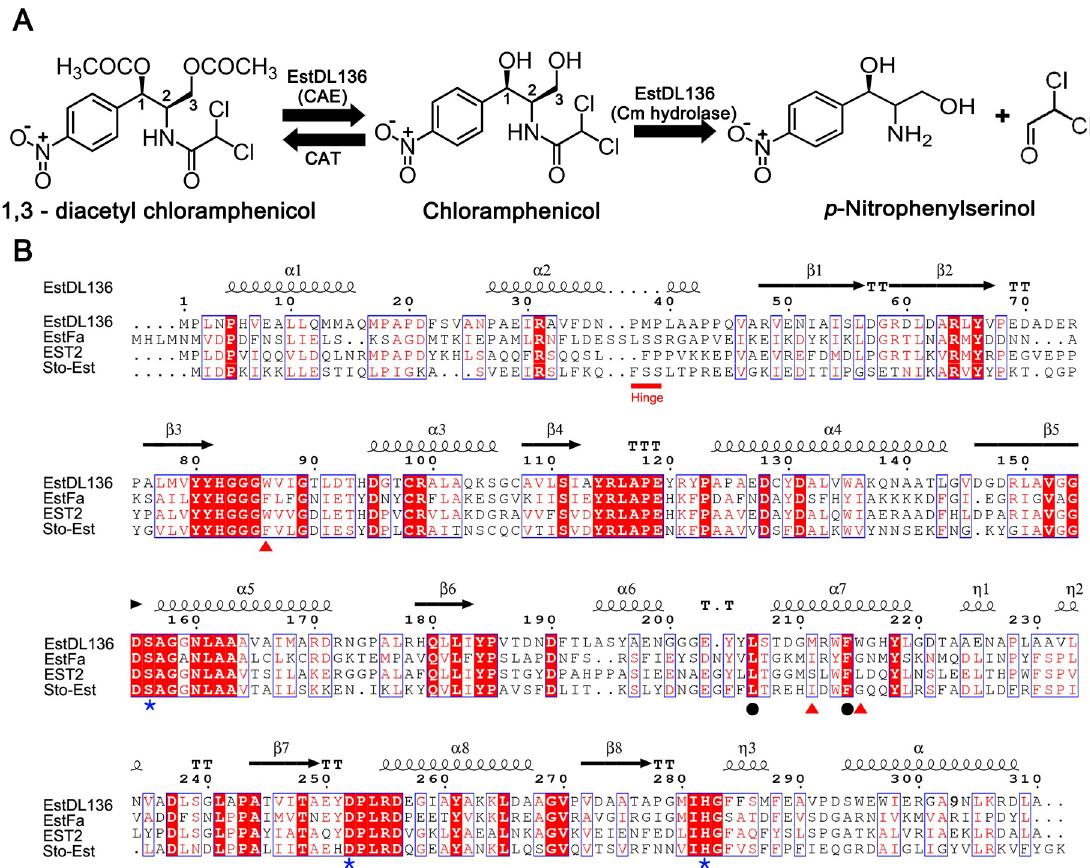
Fig 1. EstDL136 activity and sequence alignment with other HSLs. (A) The chemical structure of Cm is displayed. CAT activity allows acetylation of Cm at the C1 and C3 positions. The two different catalytic functions of EstDL136, its CAE and Cm hydrolase activities, are also illustrated. (B) The amino acid sequence of EstDL136 was compared with those of other HSLs by pairwise alignments. Three HSLs were selected for their different substrate specificities: EstFa (PDB code 3WJ2) for p -nitrophenyl-butyrate [27], EST2(M211S/R215L) mutant (PDB code 1QZ3) for p -nitrophenyl-hexanonate [26], and Sto-Est (PDB code 3AIK) for p -nitrophenyl-octanoate [28]. Highly conserved residues are shown in red and boxed in blue, whereas strictly conserved residues are displayed with a red background. Secondary structures are shown based on structural information from EstDL136( Δ PMP). Some residues that have possible roles in catalysis (blue asterisk), as possible determinants of the active site pocket (red triangles), and in the Cm-binding site (black circles) are indicated. This figure was prepared using ESPript